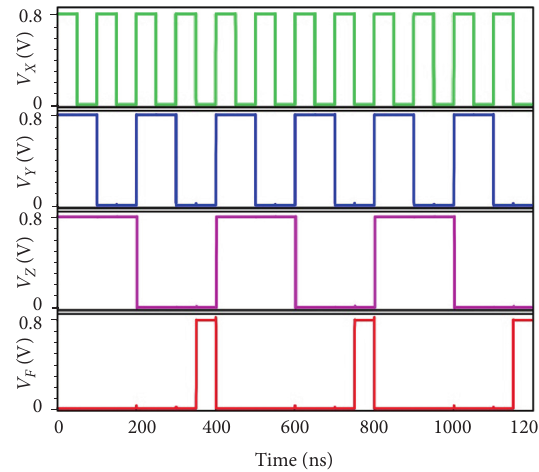
Figure 14: The simulated waveforms of the three-input NOR. Table 4: The power consumption, delay, and power delay product of the three-input NOR logic cell using PSF-TiFETdevice are compared with using single-input